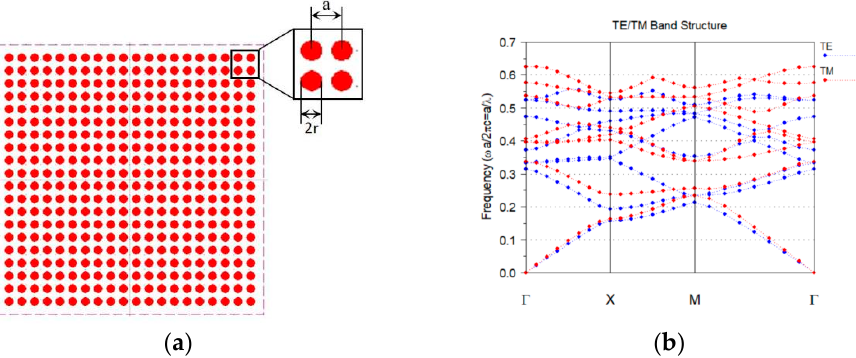
Figure 1. ( a ) Self-collimating structure; ( b ) Energy band diagram of self-collimating